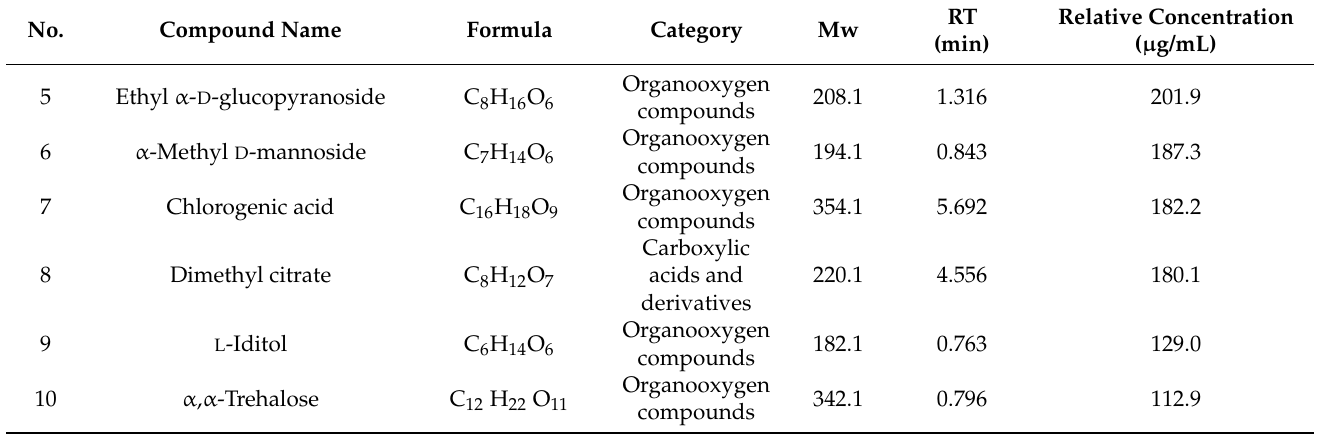
Figure 5. Different classifications of compounds and their relative contents found in EAF from Pingguoli pear fermentation broth. The different colors represented different classifications. Table 5. Identification of ten main compounds in the EAF from Pingguoli pear fermentation broth by HPLC-MS/MS.